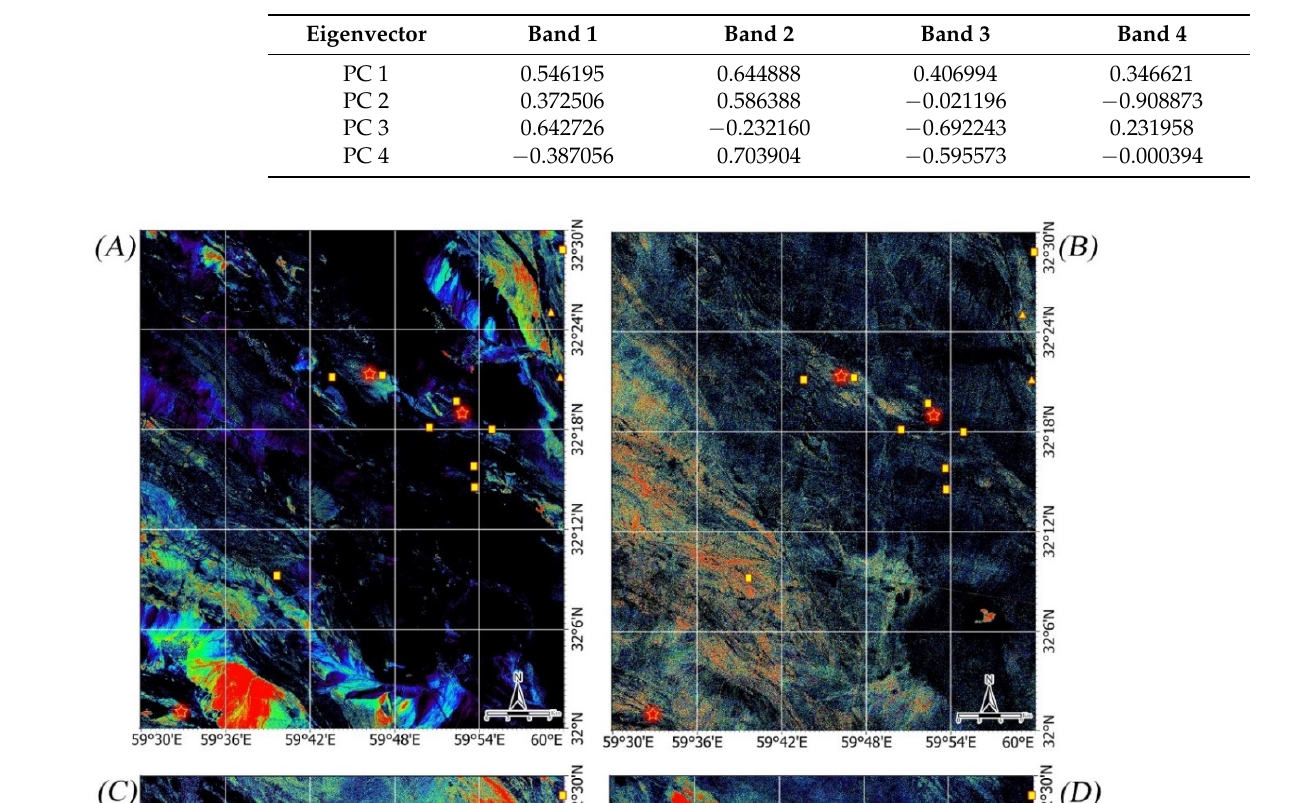
Table 7. Eigenvector matrix of selected bands for mapping propylitic zone derived from SPCA. Table 4. Eigenvector matrix of selected bands for detecting iron oxides (gossan) derived from SPCA.